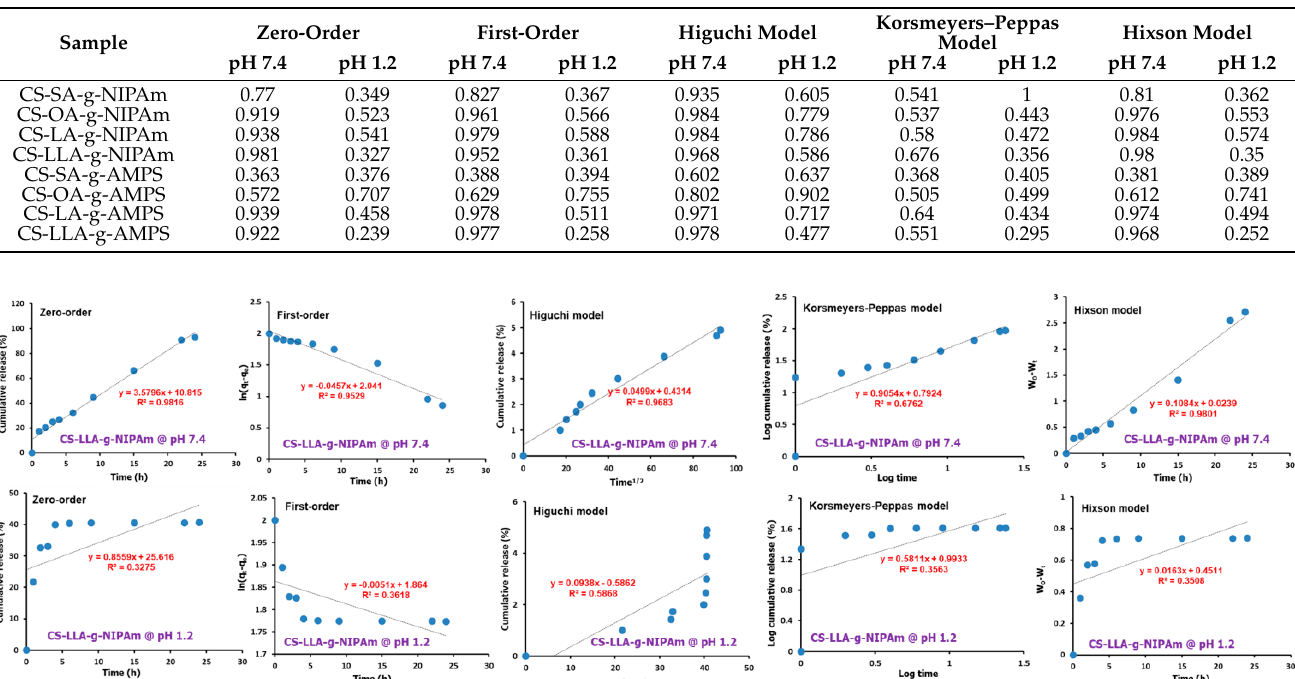
Table 3. Correlation coefficient (R 2 ) comparison of insulin release from various CS ‐ fatty acid amide derivatives with various pharmacokinetic models at two different pHs.